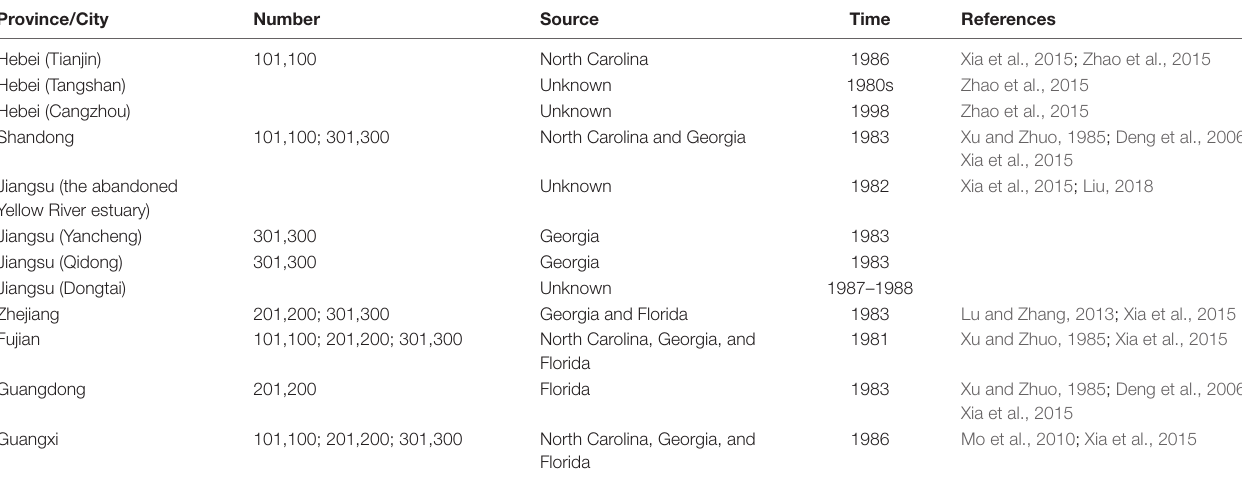
TABLE 1 | Sources of Spartina alterniflora in each population on the coast of China when it was introduced in the 1980s.